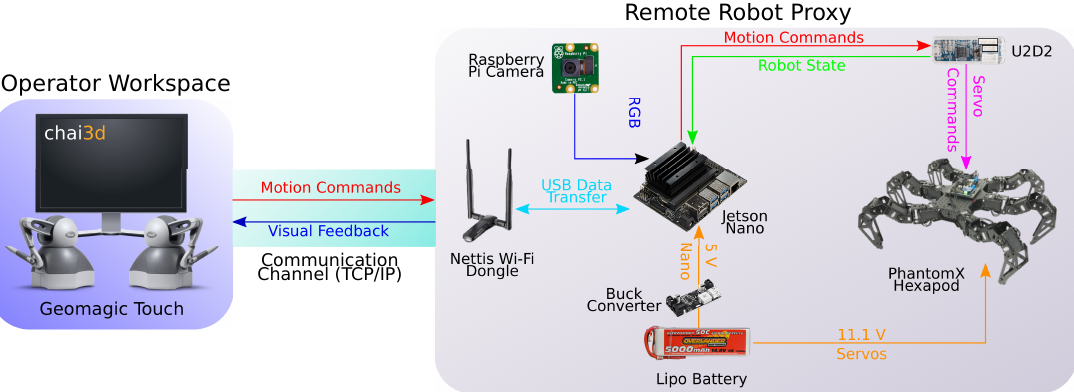
Figure 11. High level flowchart for telerobotic architecture of Experiment II.